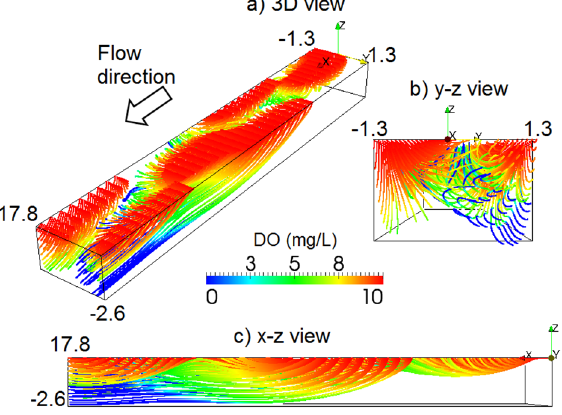
Figure 5. Snapshot of dissolved oxygen concentrations (DO) simulated within the hyporheic zone of a river with the morphological parameters of Test 5 in Table 1.